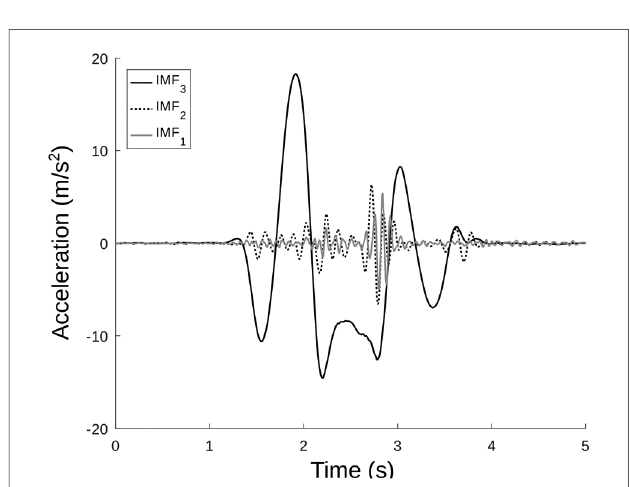
FIGURE 4 Intrinsic mode functions (IMFs) resulting from the application of the VMD algorithm on a representative CMJ. The black, dashed line represents the high frequency IMF 1 ; the gray continuous line represents the middle frequency IMF 2 ; the black continuous line represents the low frequency IMF 3 . In this speci fi c case: f 1 ¼ 6 : 06Hz; f 2 ¼ 3 : 49Hz; f 3 ¼ 0 : 55Hz.